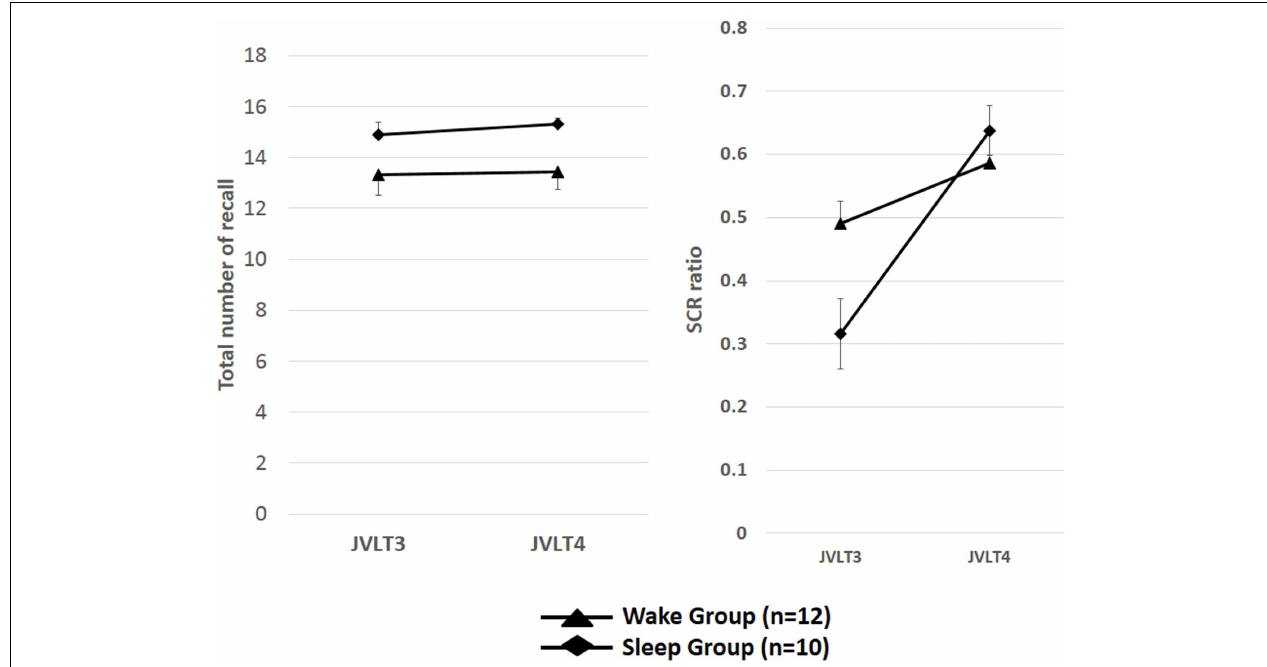
the SCR ratio [ F (1, 20) = 4.25, p = 0.01]. Subsequent analysis indicated a significant increase in the SCR ratio from the third to fourth JVLT trials only